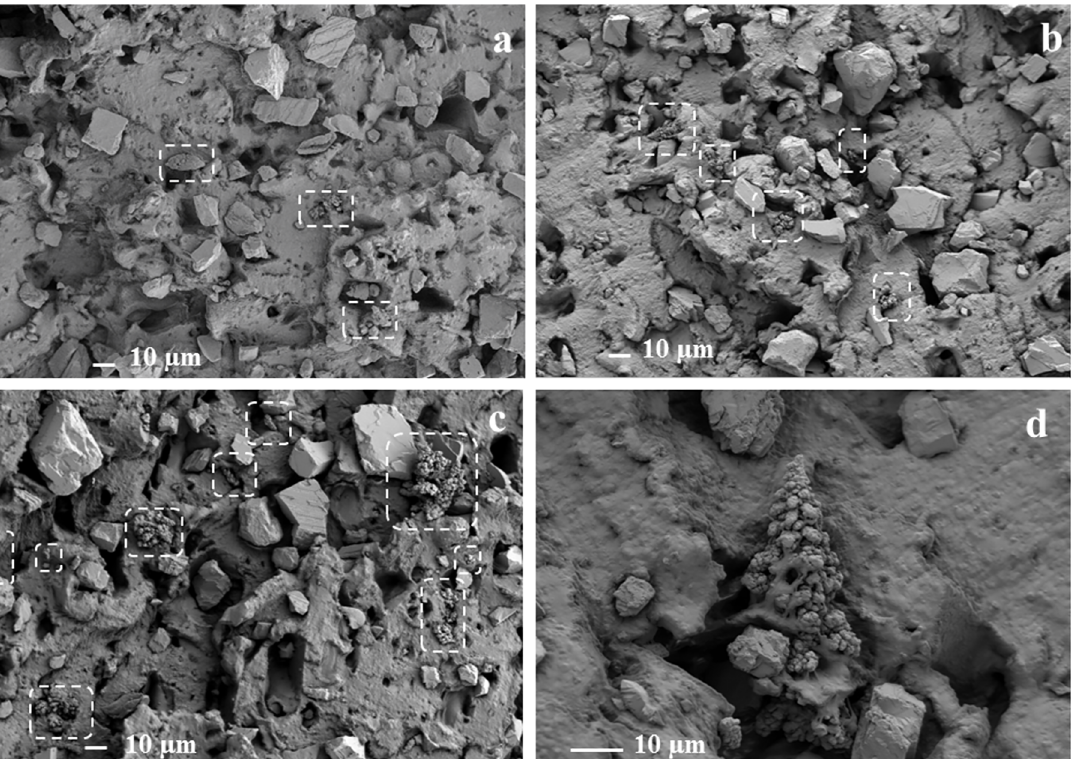
Figure 5. SEM images (a) Sample with 1% copper microparticles, (b) Sample with 2% copper microparticles, (c) Sample with 4% copper microparticles and (d) dendrite incorporated into the compound.